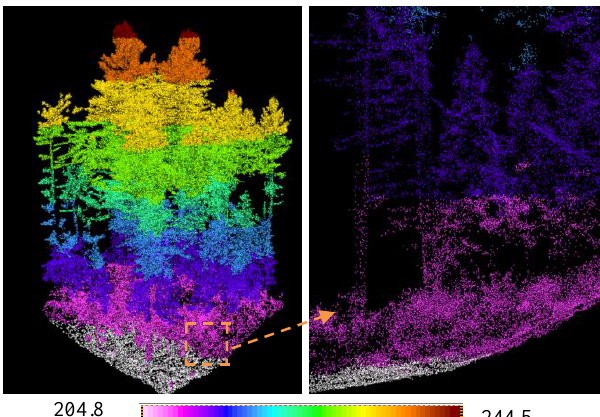
Figure 4. Lidar point cloud on a multi-storied stand (left) and enlarged details of the floor (right)